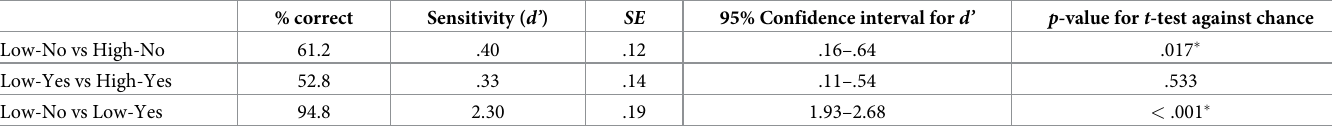
Table 1. Sensitivity values (d’) and summary statistics for discrimination between sweat from low and high self-esteem sender participants. %